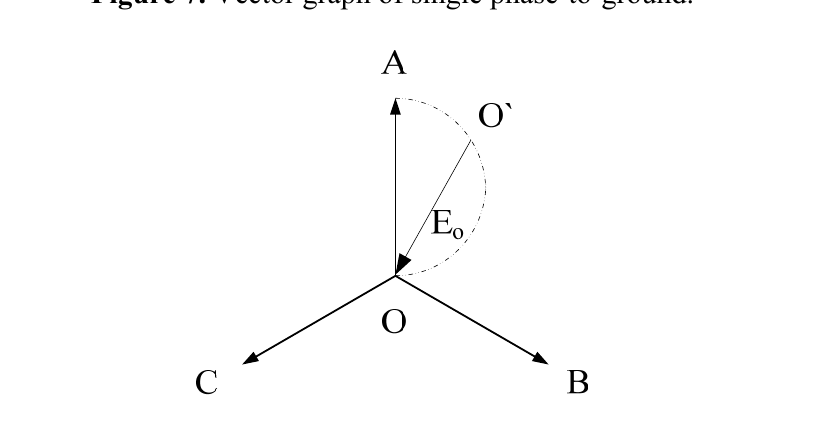
Figure 7. Vector graph of single phase-to-ground.